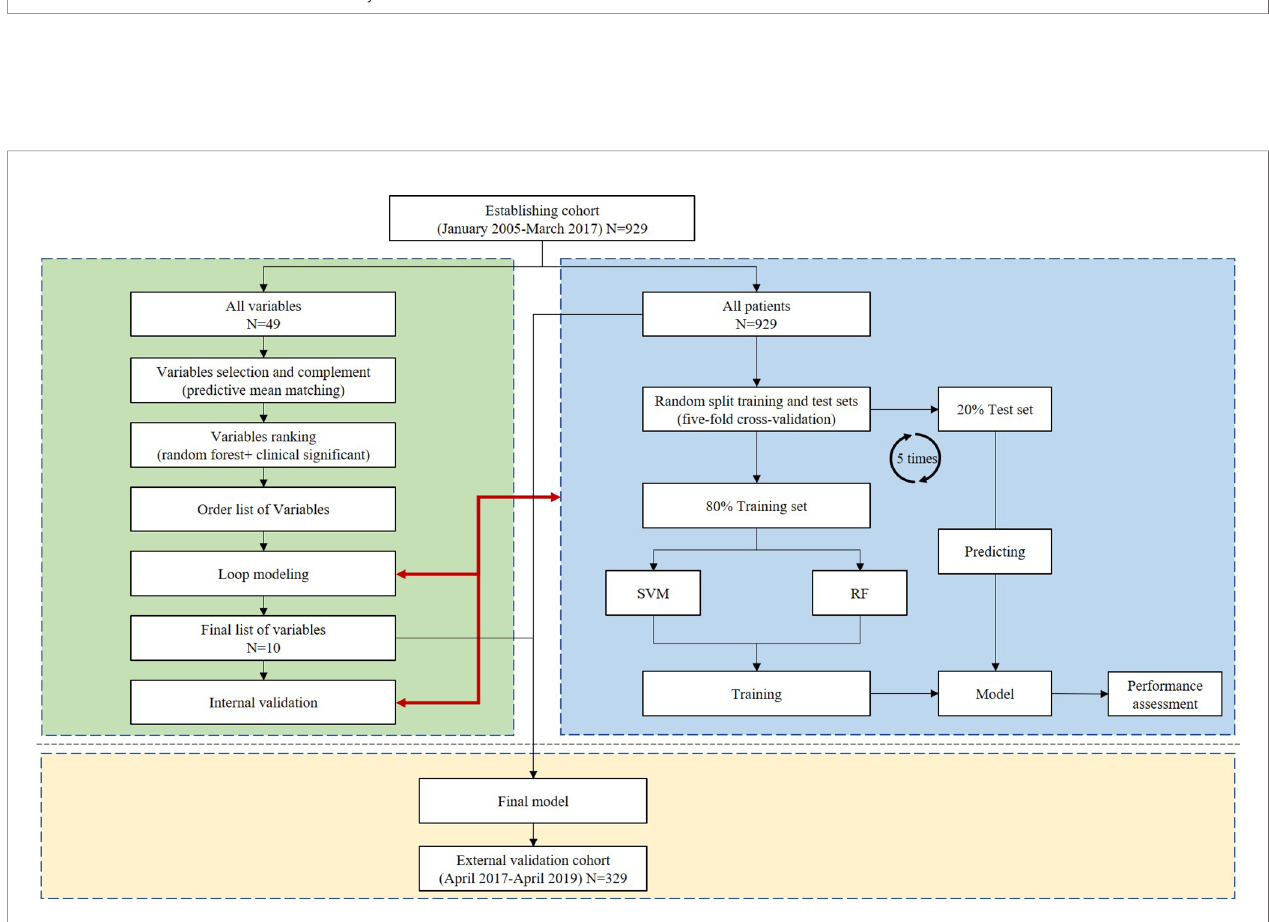
FIGURE 1 | Patient screening process. (A) Screening process for the modeling group. (B) Screening process for the external validation group. Mixed: the biopsy result is DN combined with other kind of kidney